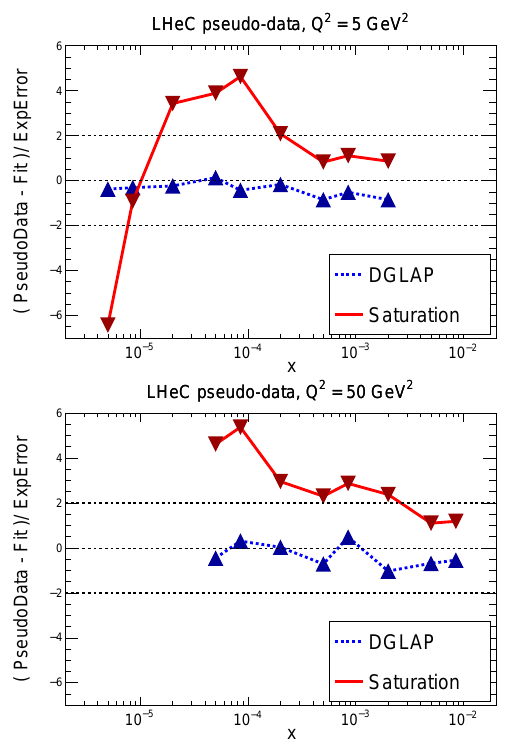
Figure 28. Pull (defined in Equation(32)) between pseudodata for reduced cross section and the fit based on DGLAP. The pseudodata has been generated either by DGLAP or by the GBW saturation model. Figure from